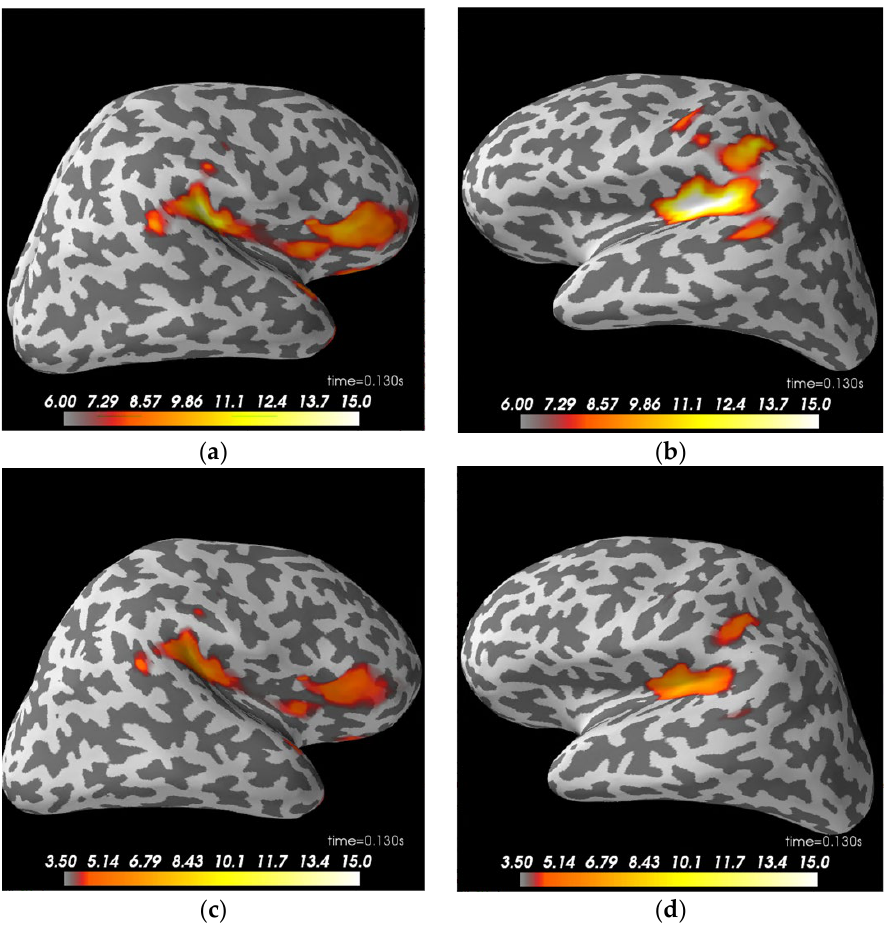
Figure 5. This figure shows dSPM source localization of the simulated data. IMF5 appears to capture higher level of activities than IMF6. ( a ) IMF5 at 130 ms in the RH; ( b ) IMF5 at 130 ms in the LH; ( c ) IMF6 at 130 ms in the RH; ( d ) IMF6 at 130 ms in the